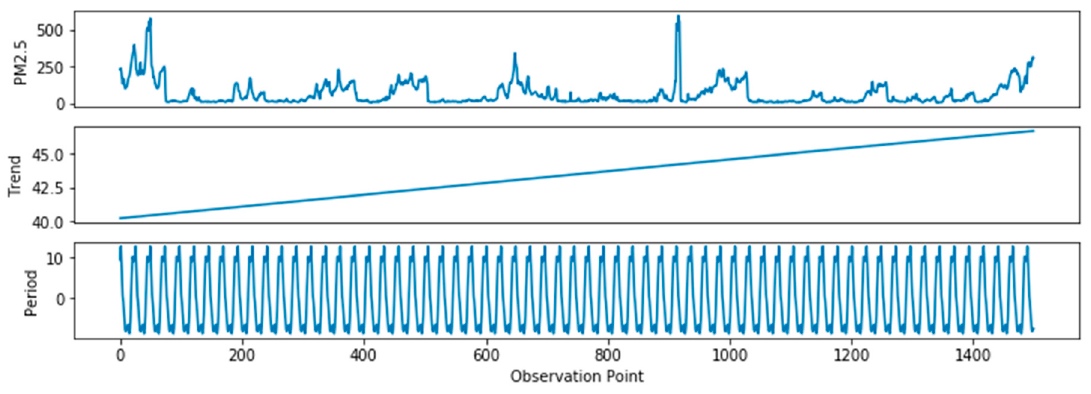
Figure 1. Decomposition of PM2.5 time series in Beijing, China.